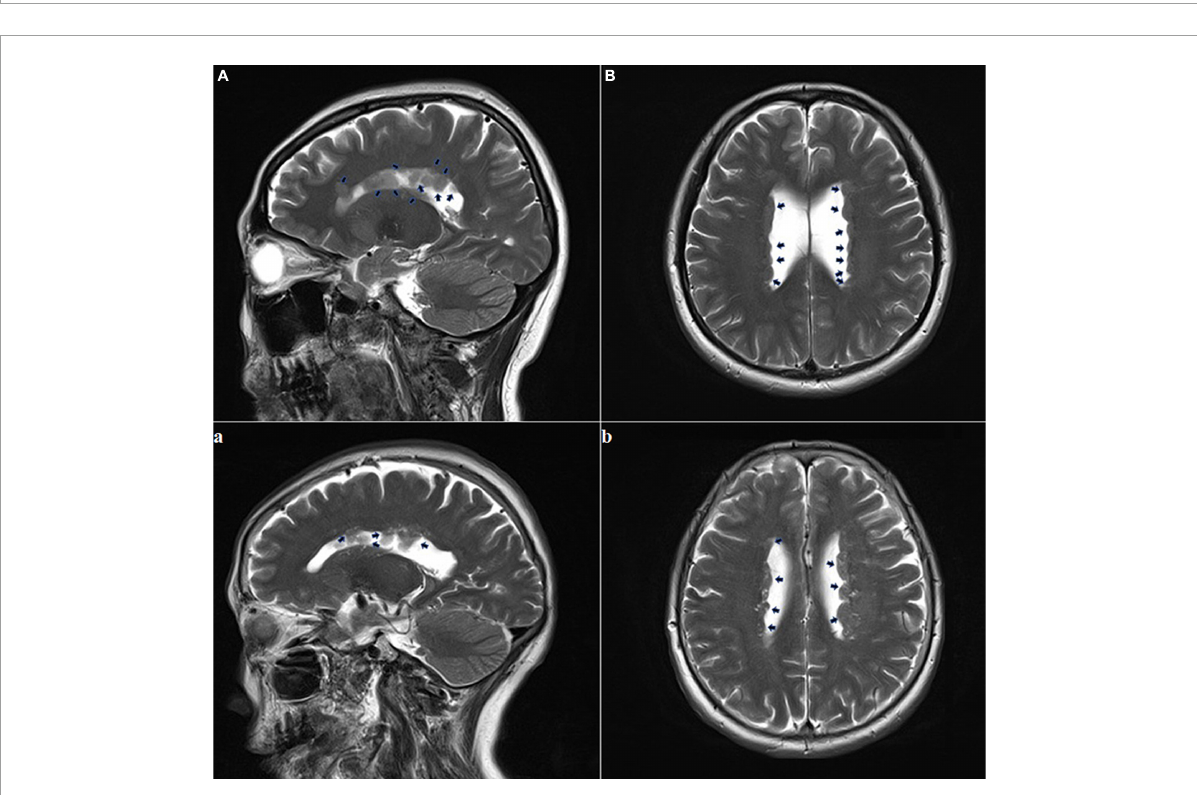
FIGURE2 Adult brain MRI images of the pregnant woman and her mother. The pregnant woman (A,B) : T2-weighted sequence performed at the age of 35 years showed multiple foci of heterotopic gray matter outlining the walls of both lateral ventricles; this is consistent with the diagnosis of subependymal gray matter heterotopia (black arrows); The pregnant woman’s mother (a,b) : T2-weighted sequence performed at 67 years of age showing multiple foci of heterotopic gray matter outlining both lateral ventricles walls (black